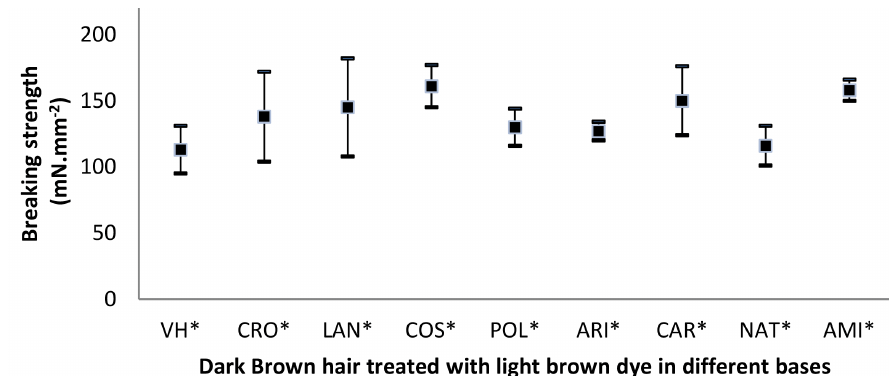
FIGURE 1 - Breaking strength for Caucasian dark brown virgin hair and samples treated with light brown oxidative hair dyes. Results categorized with equal symbols (*) mean the data didn’t present as statistically and significantly different for α = 5, p < 0.05, n = 5. VH: Virgin Hair; CRO: Cetearyl Alcohol (and) Dicetyl Phosphate (and) Ceteth-10 Phosphate/ Crodafos TM CES; LAN: Cetearyl Alcohol (and) Sodium Lauryl Sulfate (and) Sodium Cetearyl Sulfate / Lanette N TM ; COS: Cetearyl Alcohol (and) Ceteareth-20/ Cosmowax J TM ; POL: Cetearyl Alcohol (and) Polysorbate 60/ Polawax NF TM ; ARI: Ammonium Acryloyldimethyltaurate (and) VP Copolymer/ Aristoflex avc TM ; CAR: Carbomer/ Carbopol TM 980 ; NAT: Hydroxyethylcellulose/ Natrosol TM HHR ; AMI: Sclerotium gum/ Amigel TM